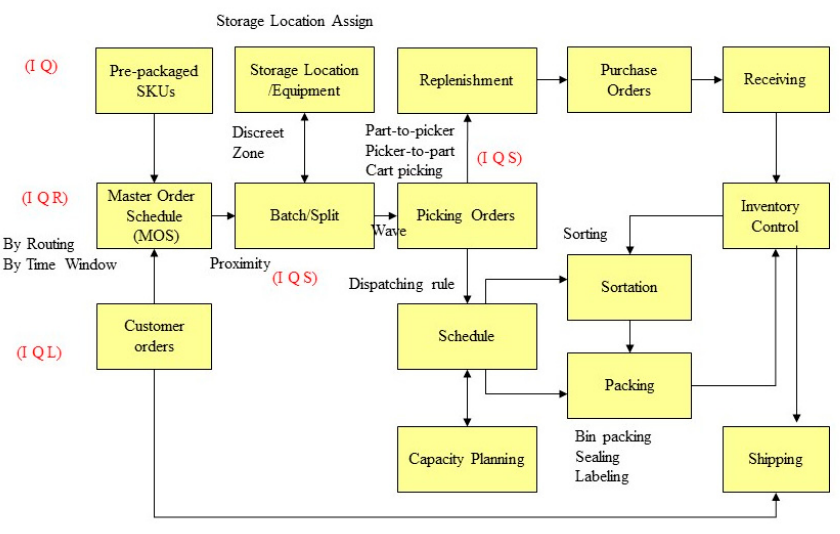
Figure 1. Forms and workflow of a warehouse management system (WMS).